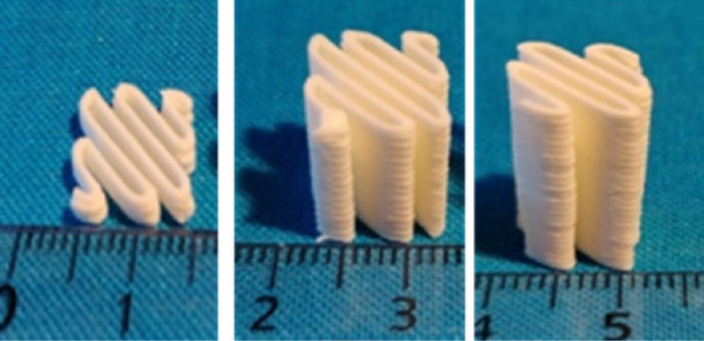
Figure 11. Three-dimensionally printed oral forms for dispersion in aqueous medium. From left to right: 125, 750 and 1000